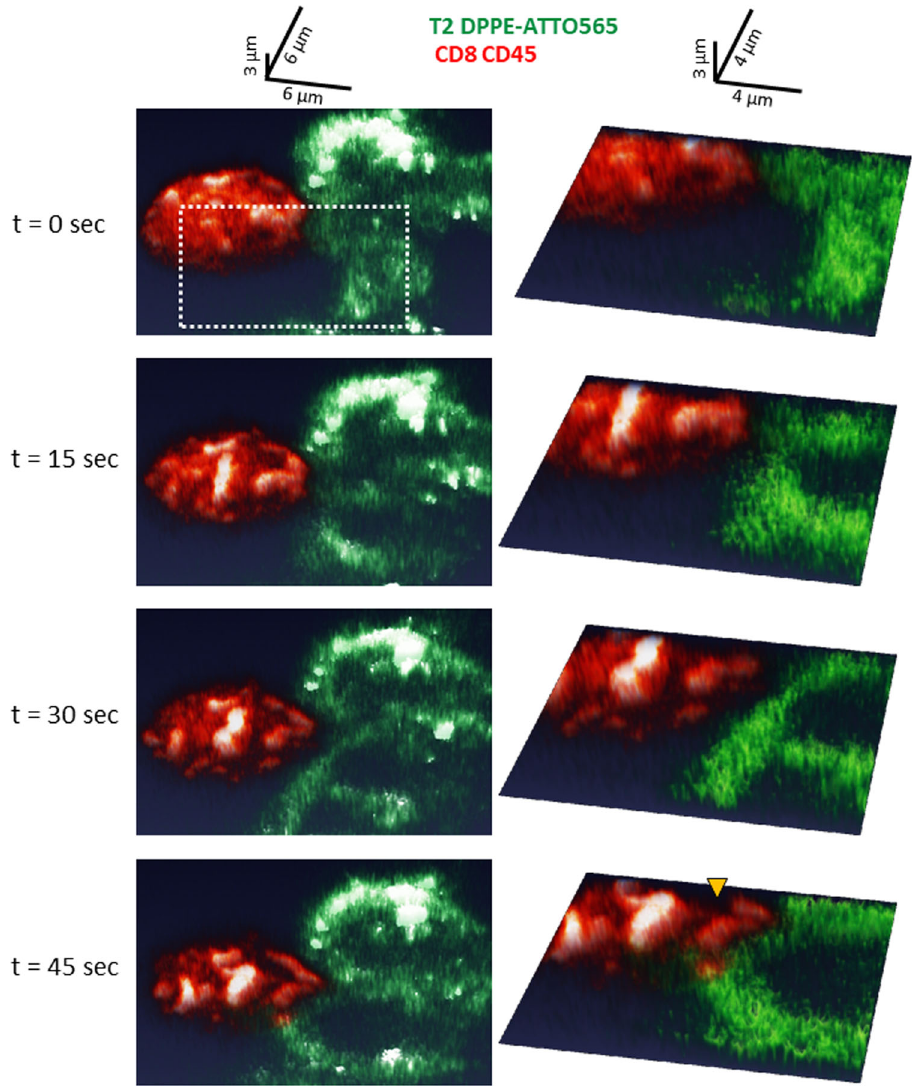
Fig. 5 Confocal imaging of a live CD8 + T cell interacting with a T2 APCs. Live-cell confocal imaging of conjugates of CD8 + T cells with T2 cells loaded with the activating peptide NY-ESO-1. The PM of the CD8 + T cells was stained for α CD45 with Alexa647 (red) and the PM of the T2 cells was stained using DPEE-Atto565 (green). Images are shown at different timepoints (t = 0, 15, 30, 45 s) from the start of the interaction (t = 0). Whole fi eld (left) and zoom images (right) are shown and rendered in two different aspects (see axes at top), to better highlight the 3D nature of the interface. All of these 2D images are projections of 3 μ m slices. The yellow arrowhead in bottom-right zoom image highlights a lamellar protrusion that facilitates the interaction between the